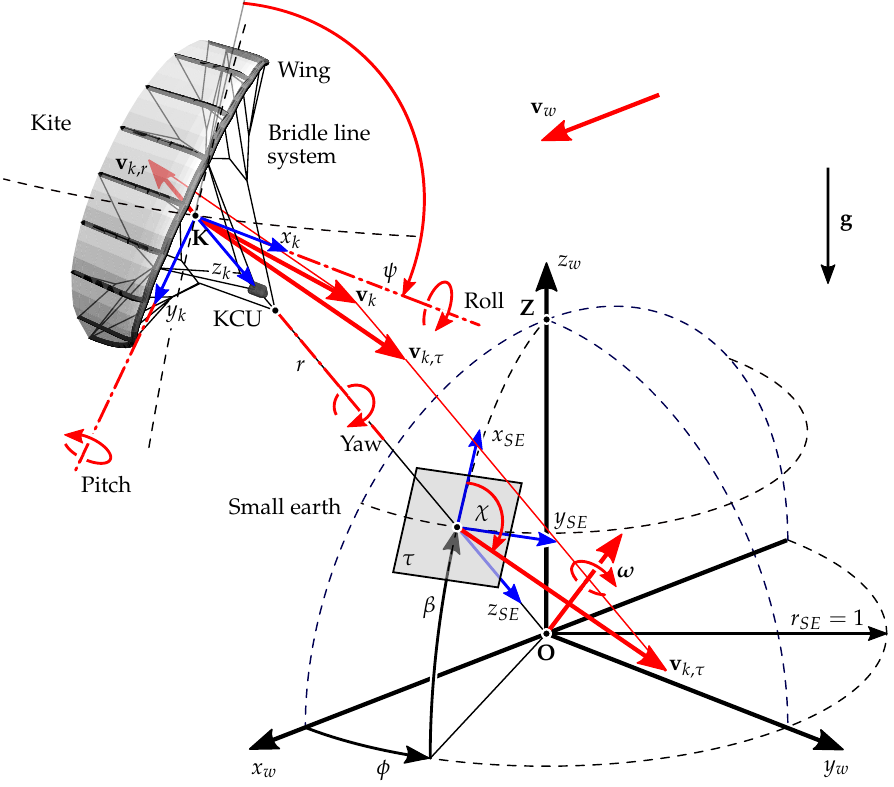
Figure 3. Reference frames to describe kite tethered flight, heading angle ψ , and course angle χ